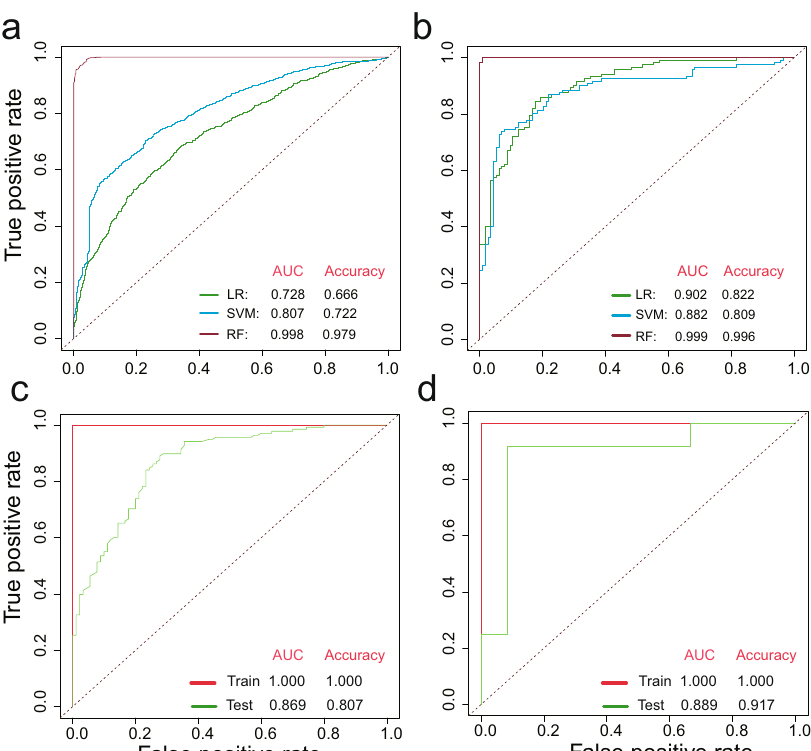
Fig. 6 The prediction models constructed by machine learning. The receiver operating characteristic (ROC) curve of models was calculated based on 32 genera ( a ) and 63 genes ( b ) with three different methods (i.e., logistic regression (LR), support vector machines (SVM), and random forests (RF)). The performance of the optimal model using 11 genera ( c ) or 6 genes ( d ) on training and test